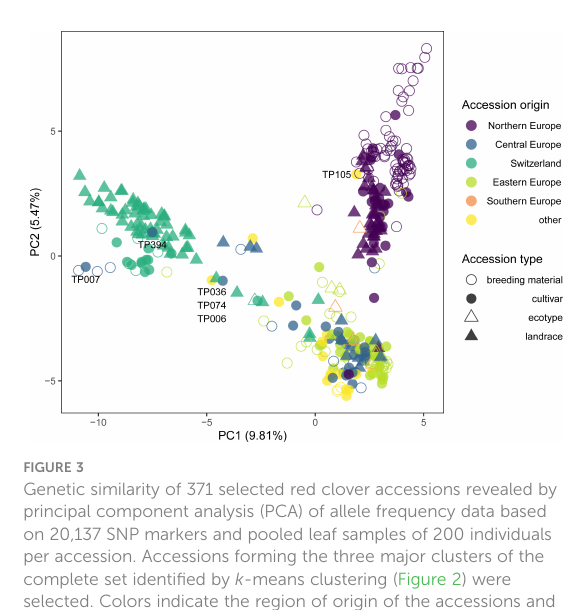
FIGURE 3 Genetic similarity of 371 selected red clover accessions revealed by principal component analysis (PCA) of allele frequency data based on 20,137 SNP markers and pooled leaf samples of 200 individuals per accession. Accessions forming the three major clusters of the complete set identi fi ed by k -means clustering (Figure 2) were selected. Colors indicate the region of origin of the accessions and symbols indicate the accession type. Accession IDs are given for selected accessions.